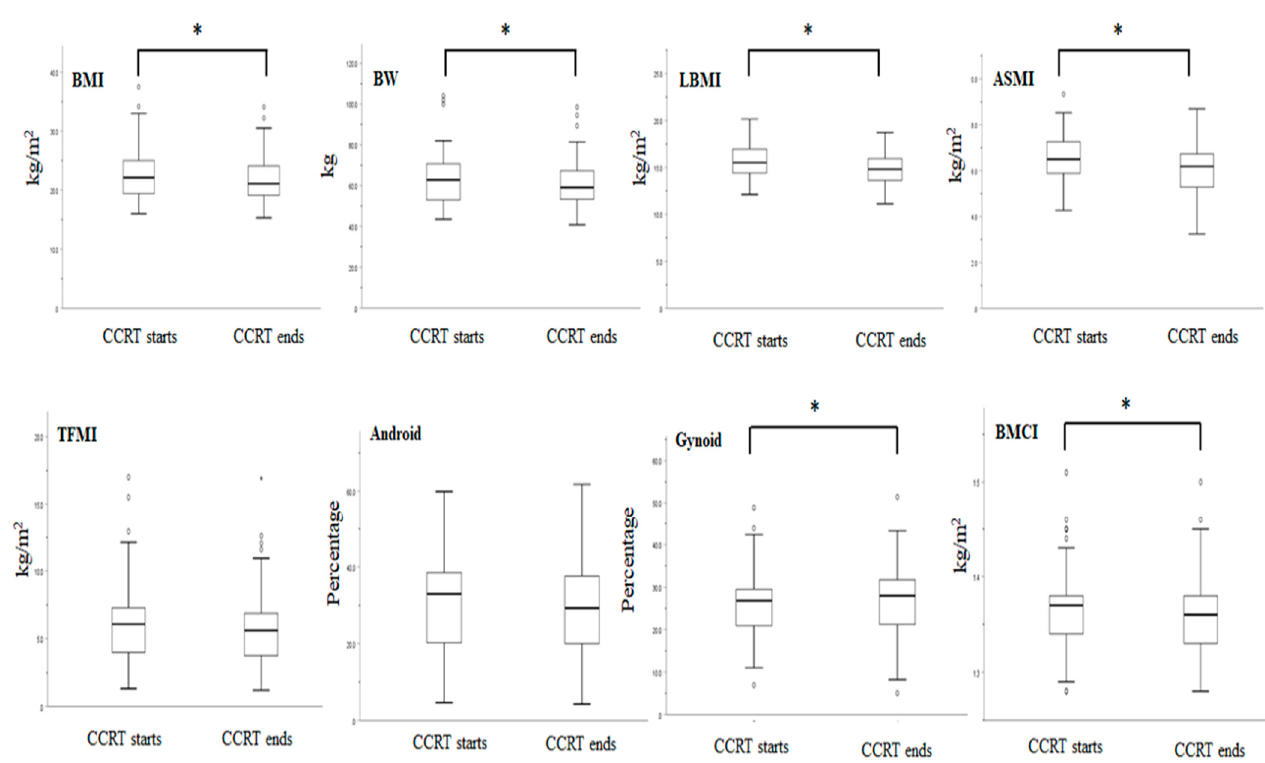
Figure 2. Box plots show the values of BMI, BW, and body composition parameters at CCRT start and end. * denotes p < 0.05, considered significant between start and end. BMI, body mass index; BW, body weight; LBMI, lean body mass index; ASMI, appendicular skeletal mass index; TFMI, total fat mass index; BMCI, bone mineral content index; CCRT, concurrent chemoradiotherapy.